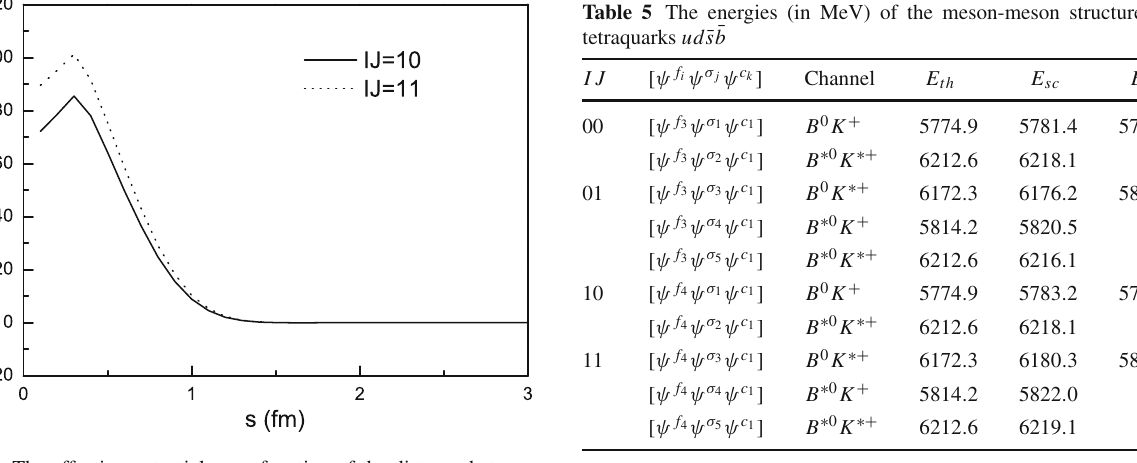
Fig. 2 The effective potentials as a function of the distance between two mesons for the I J = 10 and I J = 11 states of us ¯ d ¯ b